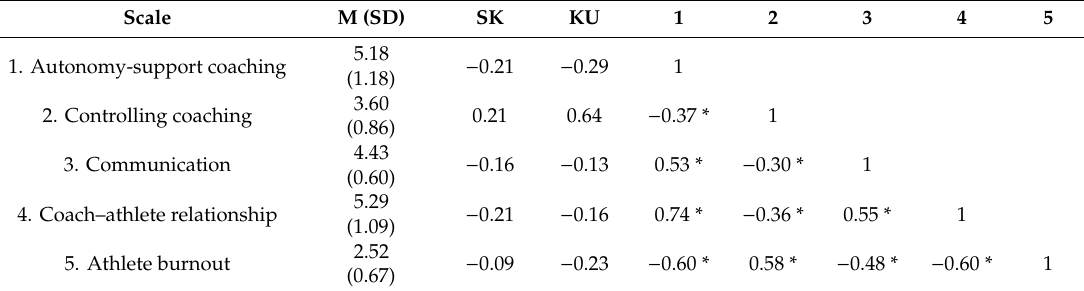
Table 2. Descriptive statistics and correlations of scale composite